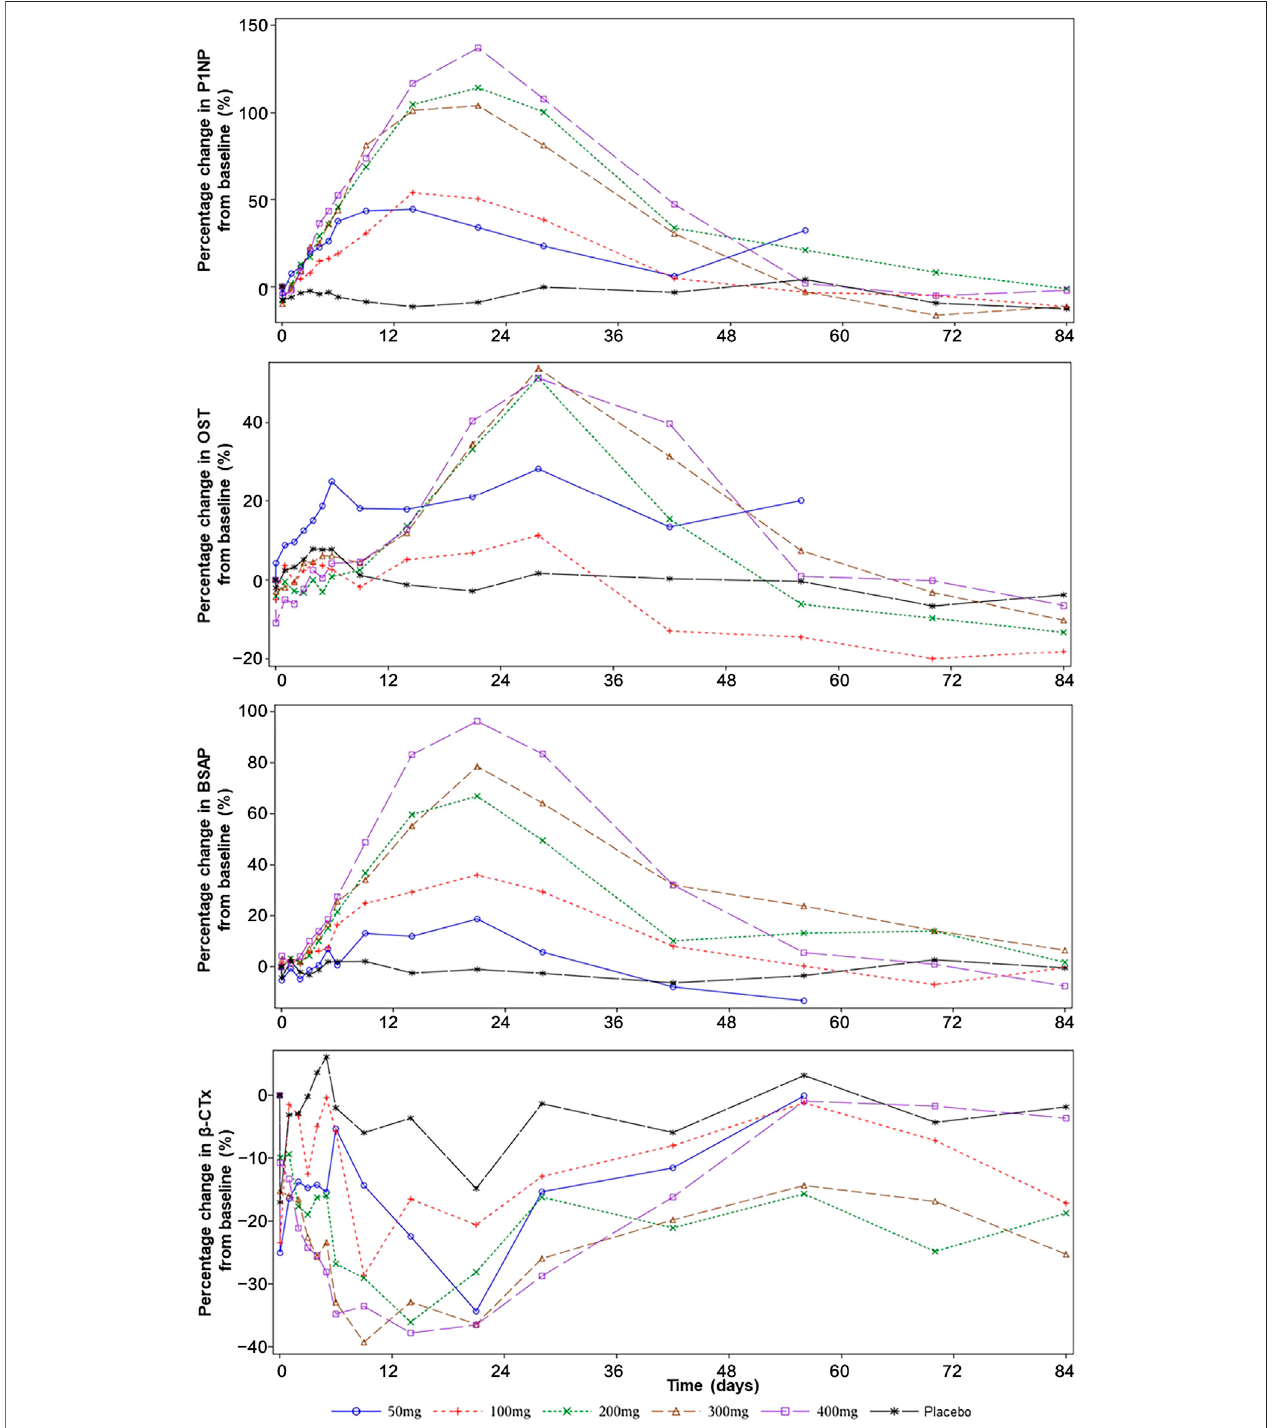
FIGURE 3 | The effect of SHR-1222 on bone turnover markers. P1NP, N-terminal propeptide of type 1 procollagen; OST, osteocalcin; BSAP, bone-speci fi c alkaline phosphatase; CTx, C-telopeptide.